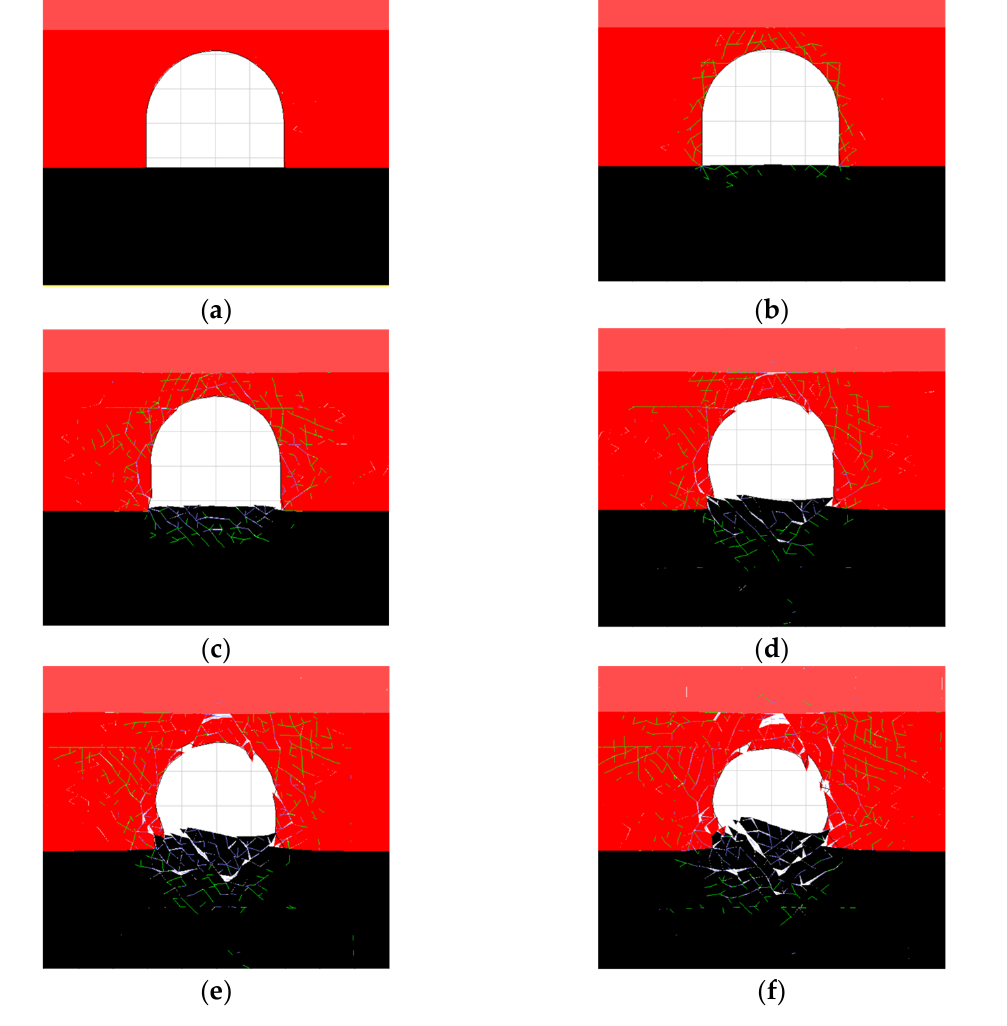
Figure 12. Distribution characteristics of cracks in roadway surrounding rock with the passage of time. ( a ) 1st d; ( b ) 5th d; ( c ) 50th d; ( d ) 200th d; ( e ) 250th d; ( f ) 300th d.